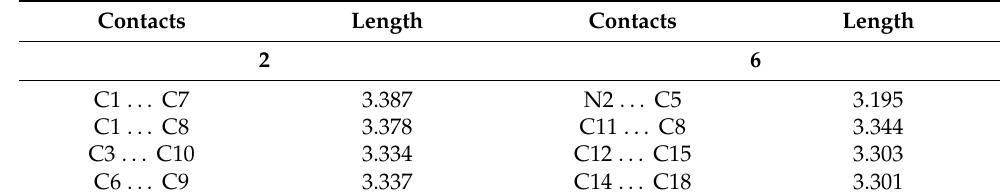
Table 4. π – π stacking for 2 and 6 [Å and ◦ ].